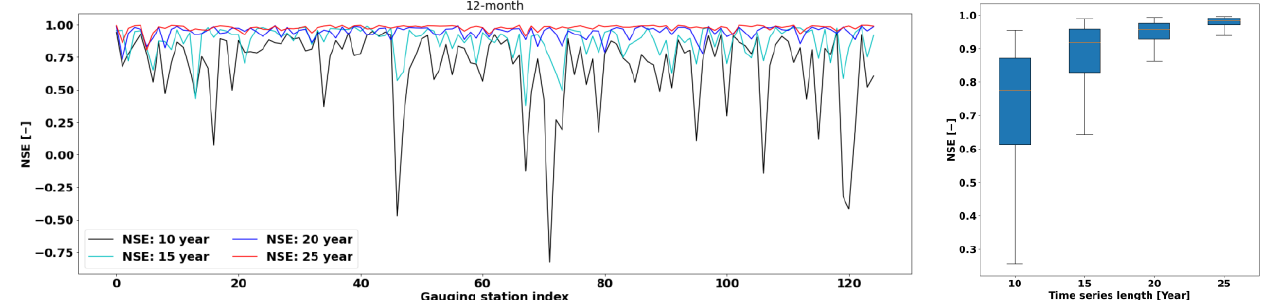
Figure 9. The variation of the NSE among 10-, 15-, 20-, and 25-year water balance data for 1-month and 12-month accumulation periods. In addition, boxplots on the side are presented to summarize the NSE from the 125 gauging stations. This is based on 10, 15, 20, and 25 years of data selected by looking at the most drought-hit